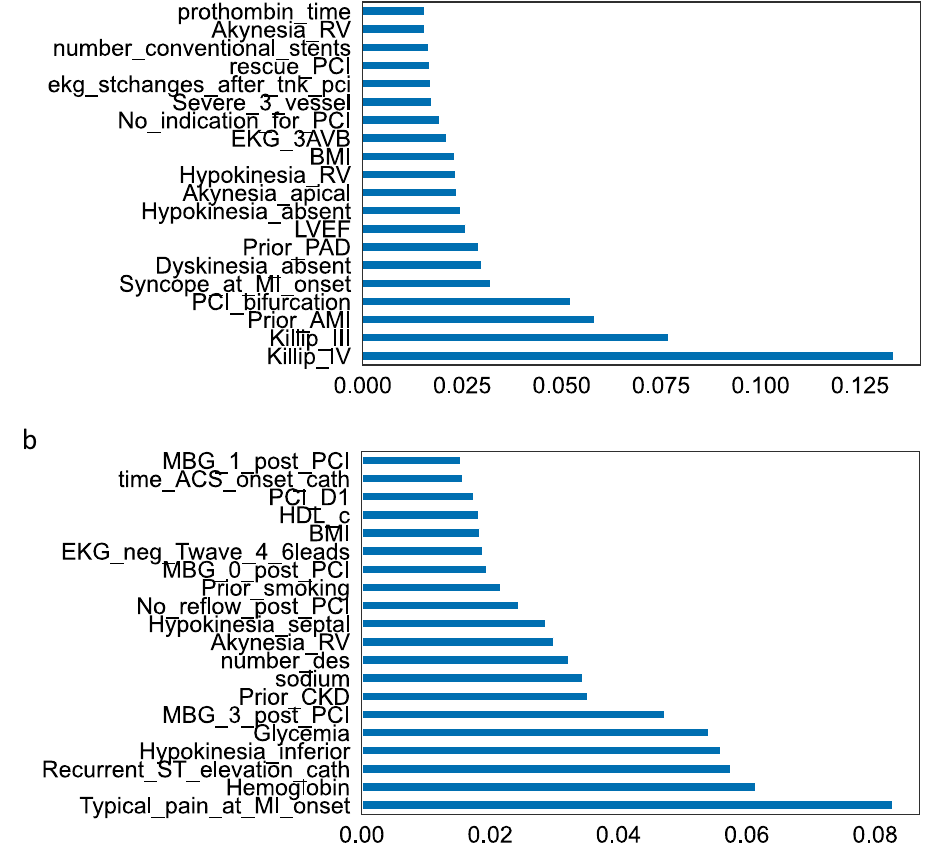
Figure 2. Predictive importance of key variables in TabNet model for in-hospital MACE. Legend: The most important predictors are listed in the y axis and explain at least 90% of variance in TabNet model for in-hospital MACE; the x axis represents the relative importance to the model. ( a ) the global cohort and ( b ) young individuals with ACS (≤ 55 years old). Prothrombin_time: prothrombin time; Akynesia_RV: right ventricular akinesia; number_conventional_stents: number of conventional stents; rescue_PCI: treatment with recue PCI due to absent reperfusion sygnals after thrombolysis in STEMI; PCI: percutaneous coronary